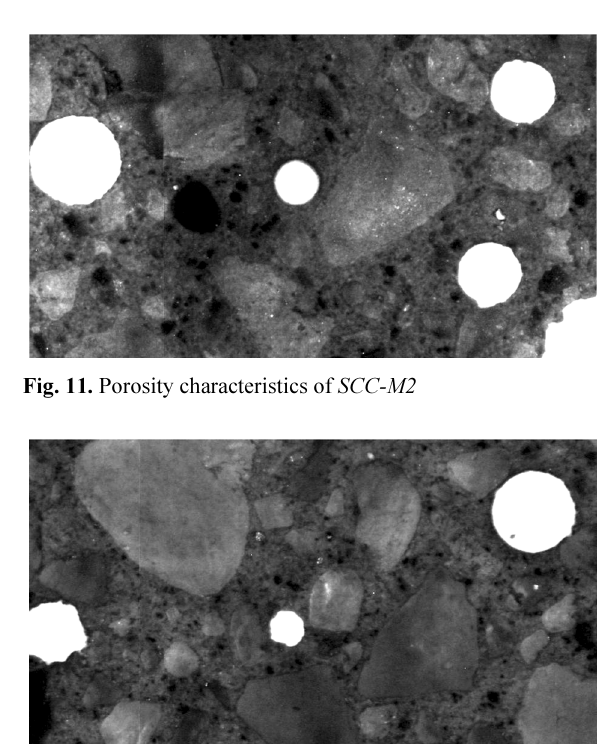
Fig. 10. Porosity characteristics of SCC-M1